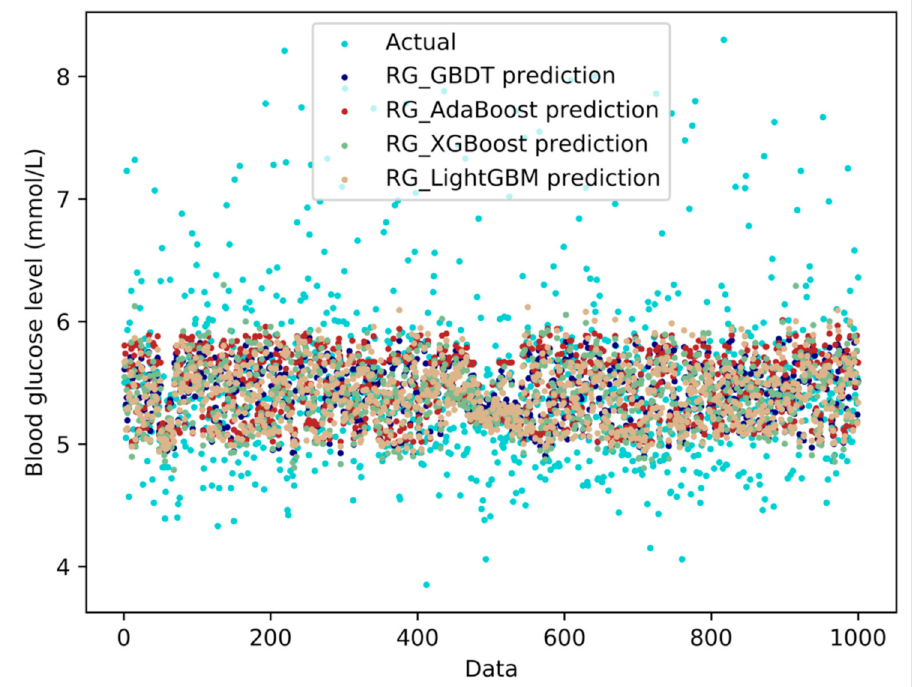
Figure 17. The scatter plot diagram of the actual and predicted blood glucose (fasting/pre-prandial) levels by the RG-enriched